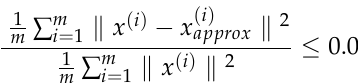
Figure 6. PCs Chart.